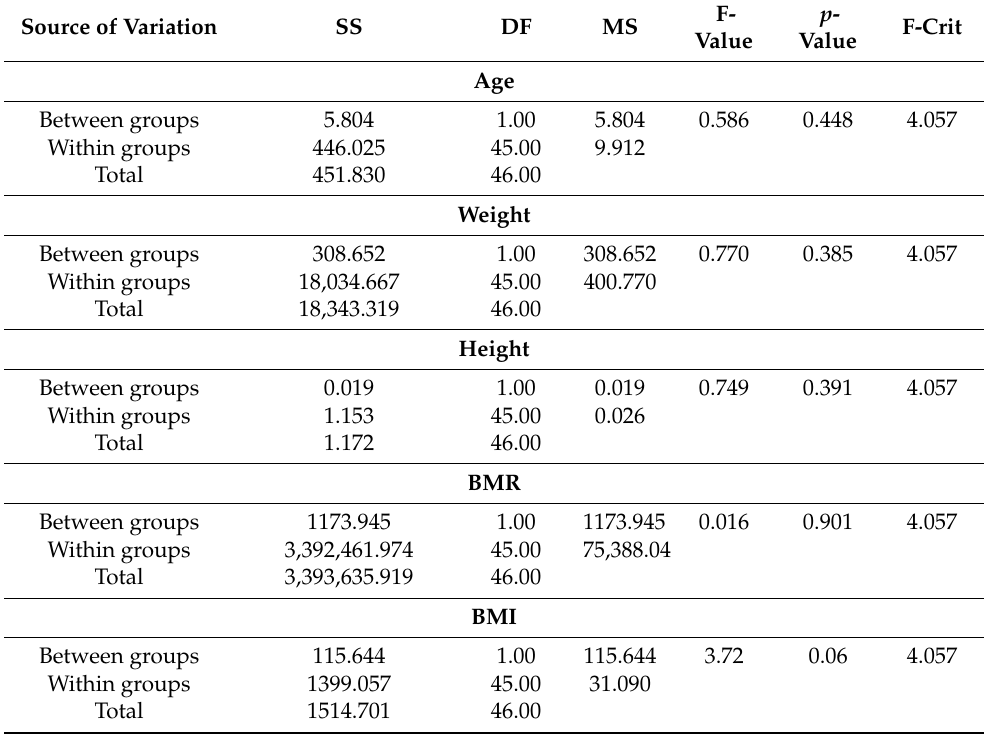
Table 6. Analysis of variance for physiological